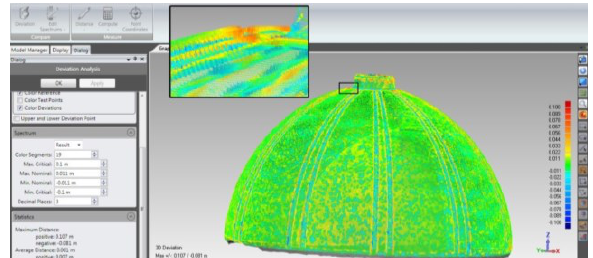
Figure 6. Comparison between model and point cloud